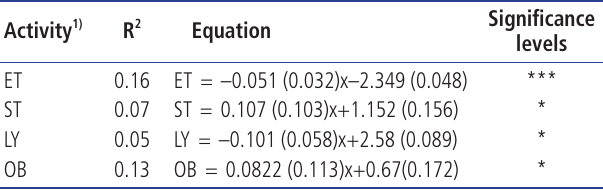
Table 7. Regression equations of behavioral activities of pigs fed Vachellia tortilis leaf meal Activity 1) R 2 Equation